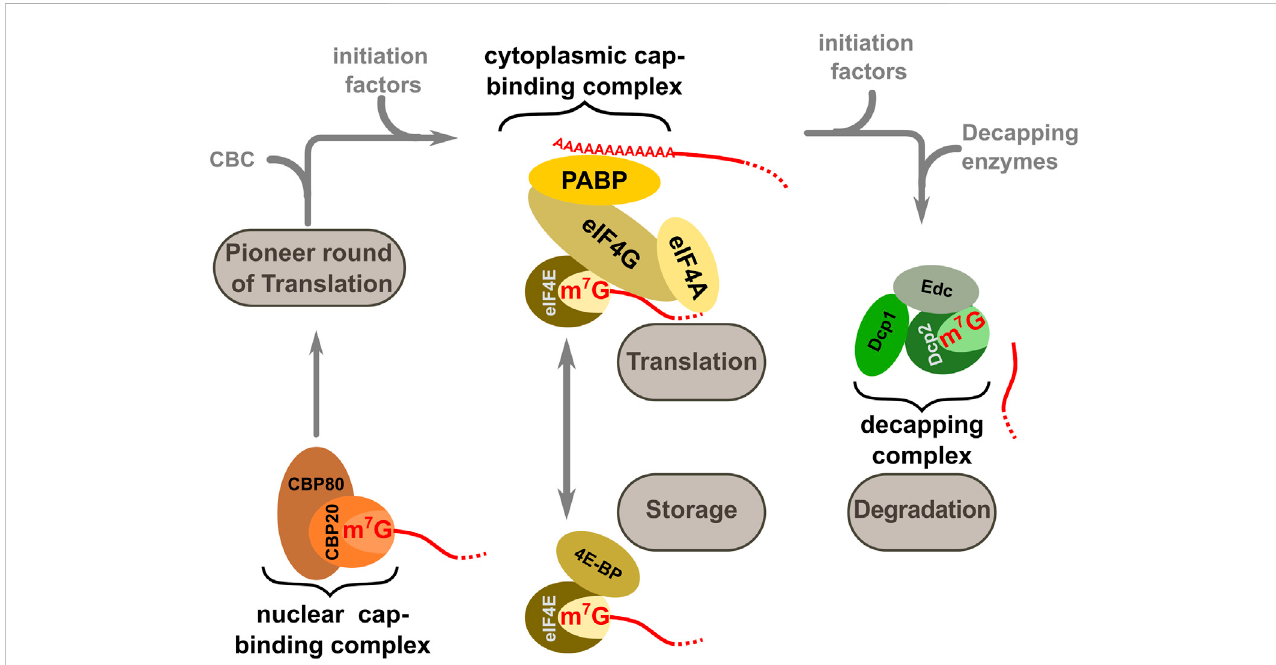
Different cap-binding complexes mediate entry into and exit from the translational state of mRNAs in the cell. The nuclear cap binding complex CBC (consistingofCBP20andCBP80)ispresentduringnuclearprocessingevents.Followingexport,thiscomplexisexchangedagainstacytoplasmiccap-binding complex comprising members of the eIF4 group of translation factors and the poly(A) binding protein PAB (this complex is collectively termed eIF4F). The productive eIF4F complex can be temporarily disrupted by the 4E binding proteins or 4E-BPs and in this inactive form transcripts may be stored in speci fi c cellular structures such a P-bodies. At the end of the translationally active phase the eIF4F complex is disassembled and replaced by the decapping